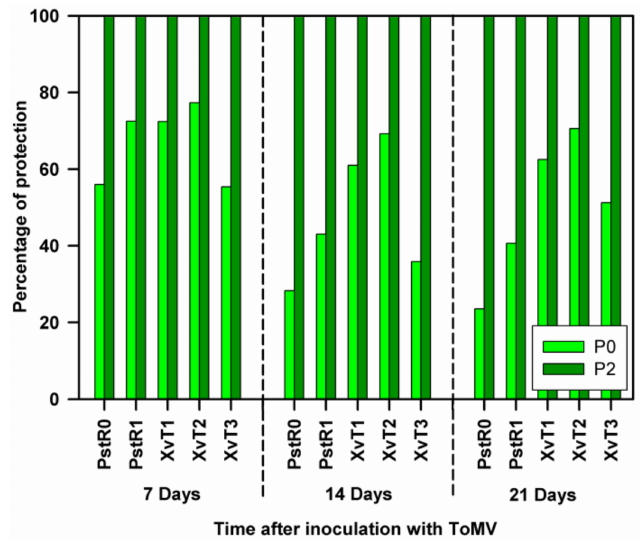
Figure 3. E ff ect of protection against Pst (R0, R1) and Xv (T1, T2, T3) on tomato plants cv. Moperou after pre-inoculation with the ToMV incompatible strain (GM-0) P0 and with the compatible (J) strain P2 (7, 14 and 21